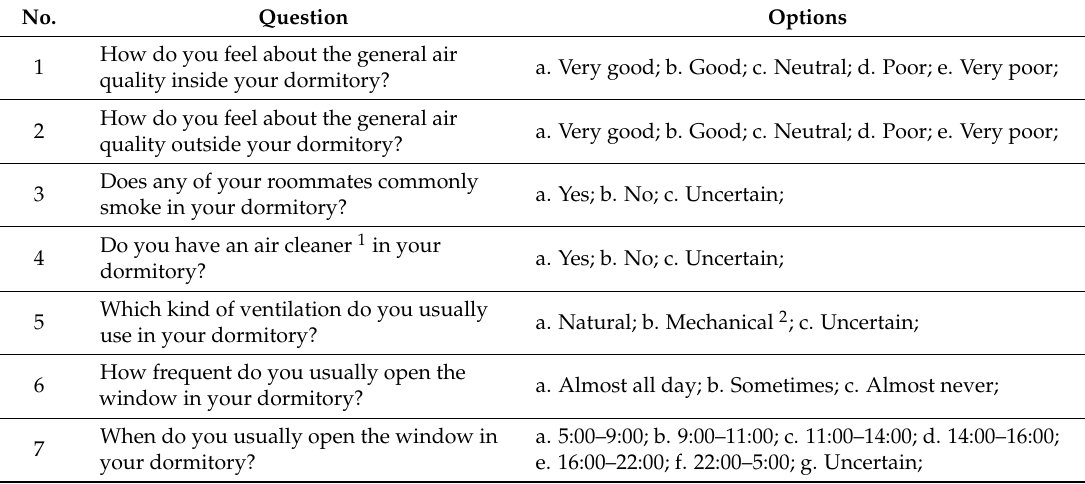
Table 1. Occupant perceptions and behavior patterns in the